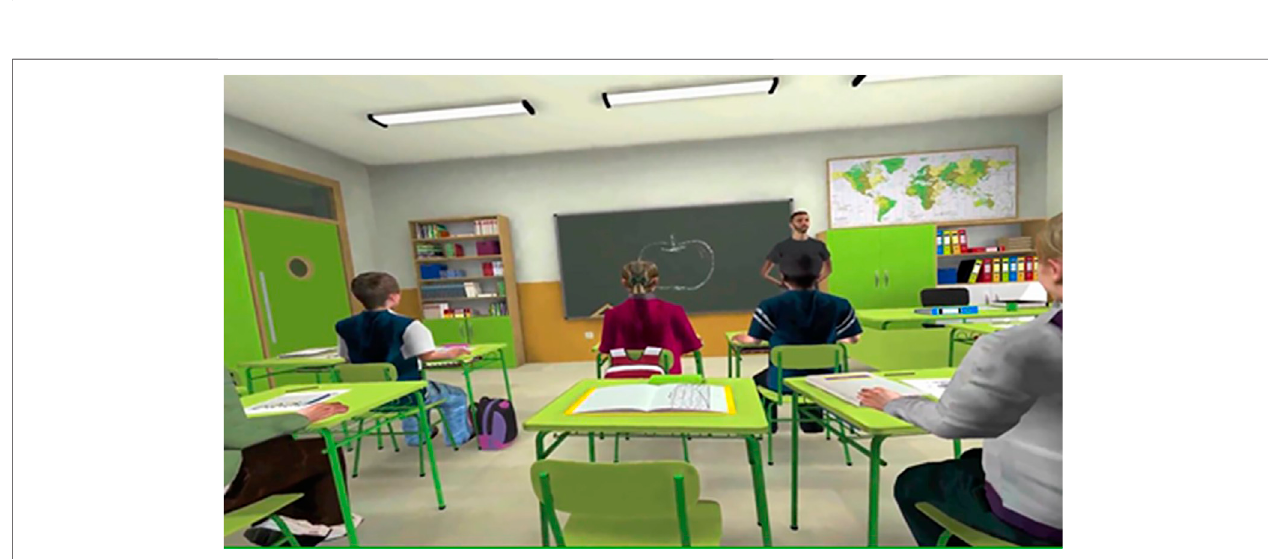
FIGURE 3 | AULA Nesplora Virtual Classroom (norms for N (cid:1) 1,272 participants). Reprinted with permission (Diaz-Orueta et al., 2020).